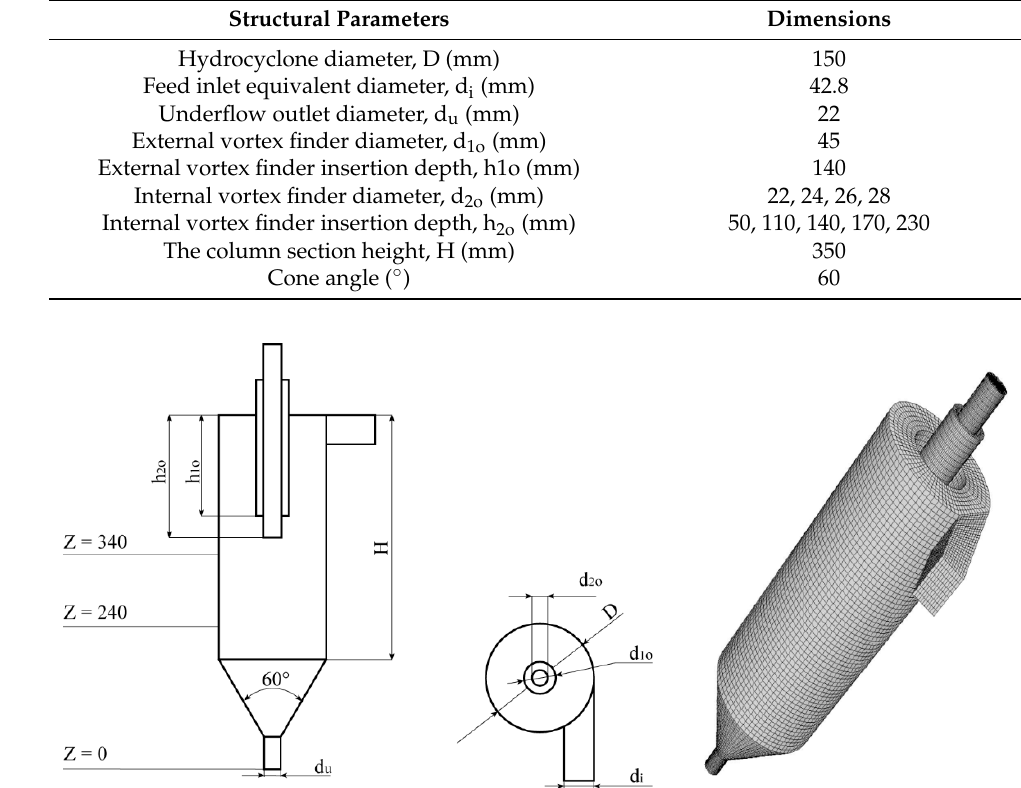
Table 1. Structure parameters of double overflow three-product hydrocyclone.